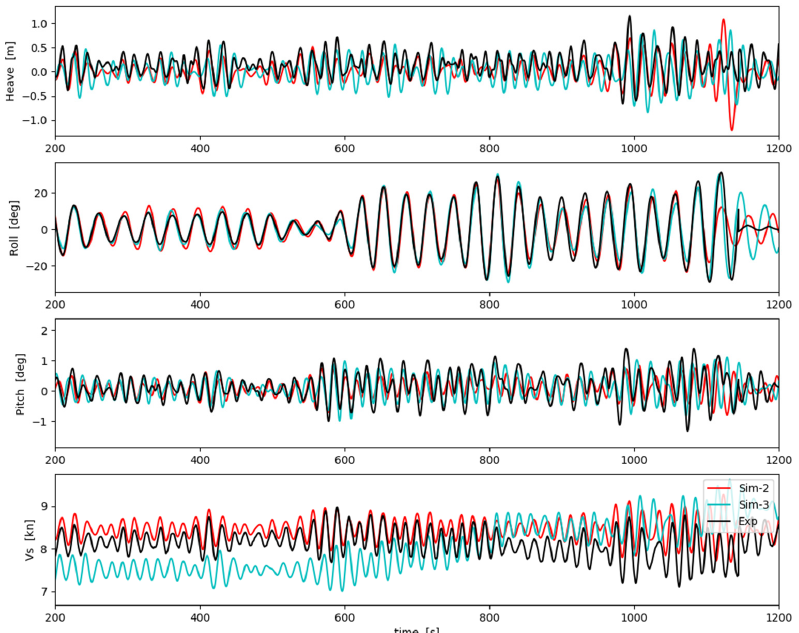
Figure 12. Results of a first case of a deterministic comparison of a parametric roll event in irregular following seas (Jonswap spectrum, Hs = 4.0 m, Tp = 13.5 s, γ = 3.3), vs. ≈ 8 kn. Heave, roll, pitch and vessel speed calculated by Sim-2 and Sim-3 are compared to the measurement.